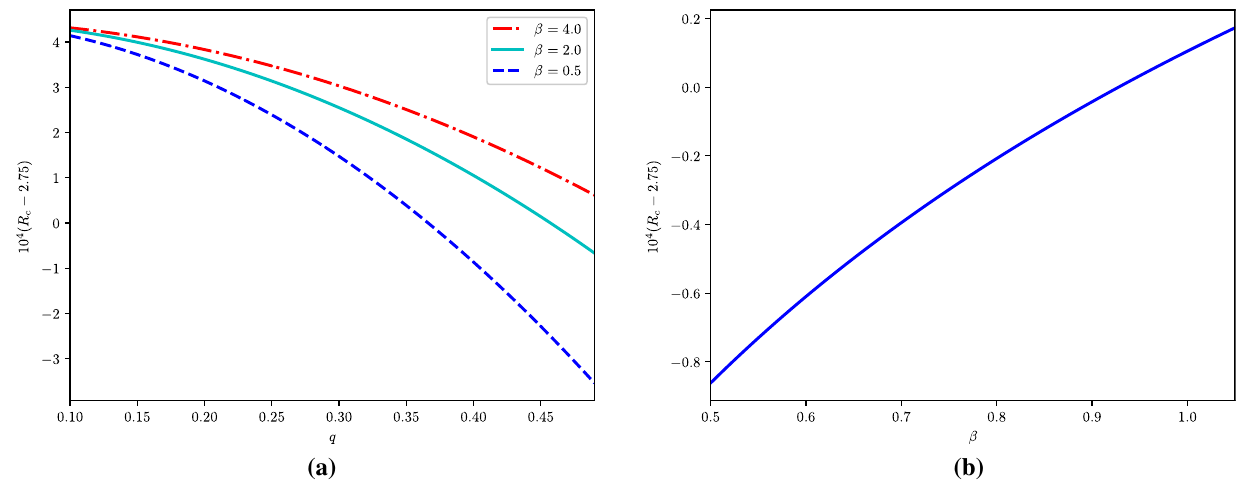
Fig. 2 Point source: the dependence of the radius of screening with a precision of 0.9 on a the charge q and b the strength of self-interaction β (for q = 0 .